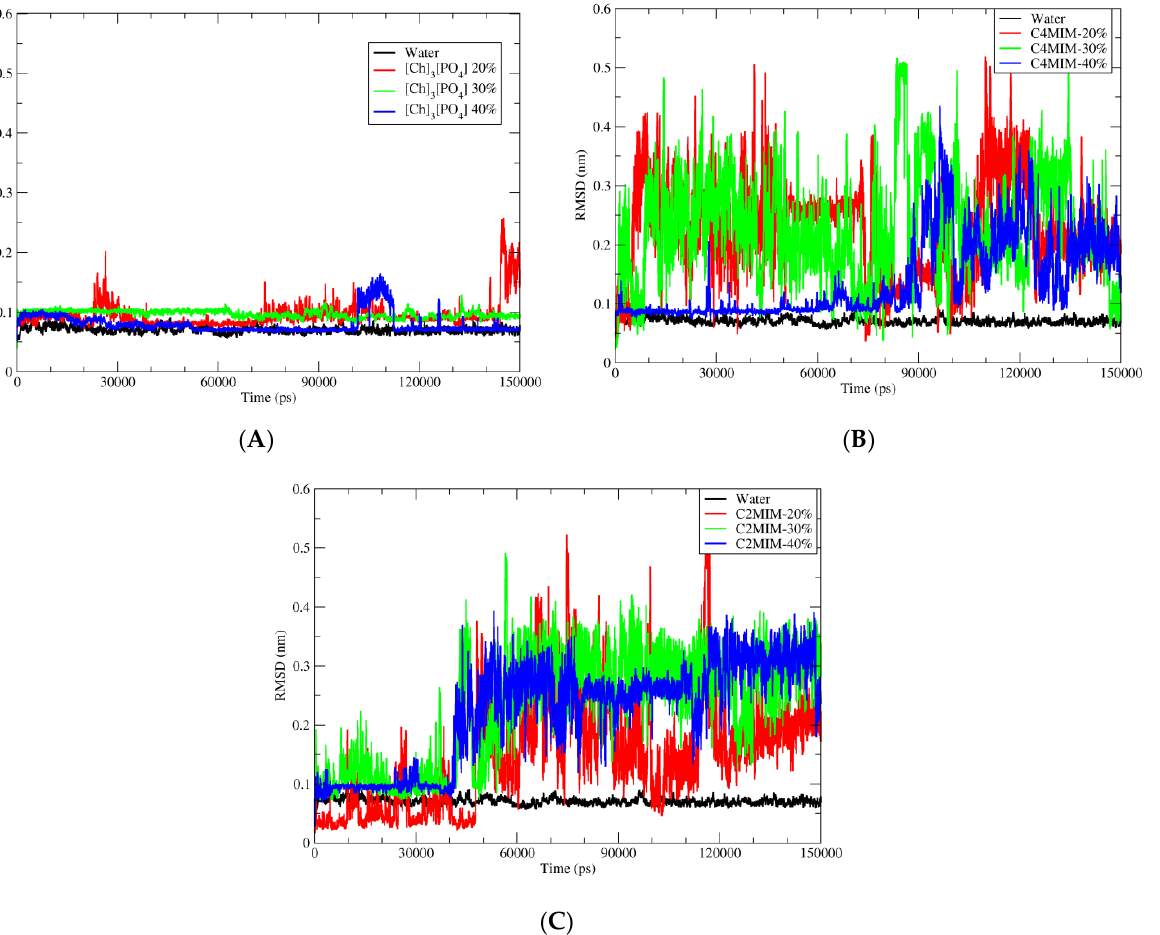
Figure 4. Root mean square deviation (RMSD) of BHET with respect to PETase in water and three different ionic liquids solutions. ( A ) Pure water in black; 20% of [Ch] 3 [PO 4 ] in red; 30% of [Ch] 3 [PO 4 ] in green and 40% of [Ch] 3 [PO 4 ] in blue. ( B ) Pure water in black; 20% of [C4MIM][Ac] in red; 30% of [C4MIM][Ac] in green and 40% of [C4MIM][Ac] in blue. ( C ) Pure water in black; 20% of [C2MIM][Ac] in red; 30% of [C2MIM][Ac] in green and 40% of [C2MIM][Ac] in